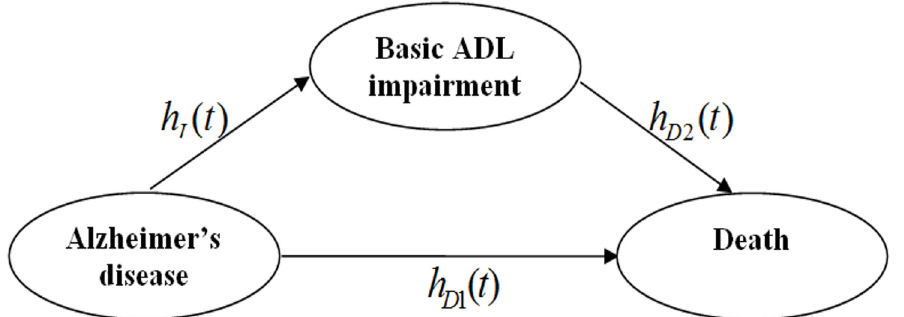
Fig 1. Three-state Markov chain used to derive predictive value of basic ADL impairment. h I (t) is the hazard rate for the time to basic ADL impairment. h D 1 (t) is the hazard rate for the time to death among basic ADL-intact patients. h D 2 (t) is the hazard rate for the time to death among basic ADL-impaired patients. The transitions between disease onset, development of basic ADL impairment, and death were modeled by quantifying the effect of baseline characteristics on basic ADL impairment and survival as well as the effect of developing basic ADL impairment on